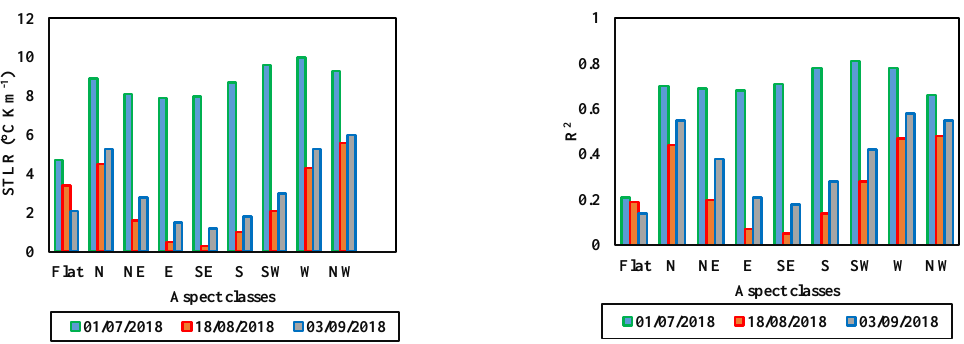
Figure 5. The NSTLR and R 2 values in different classes of aspects in the study area at different